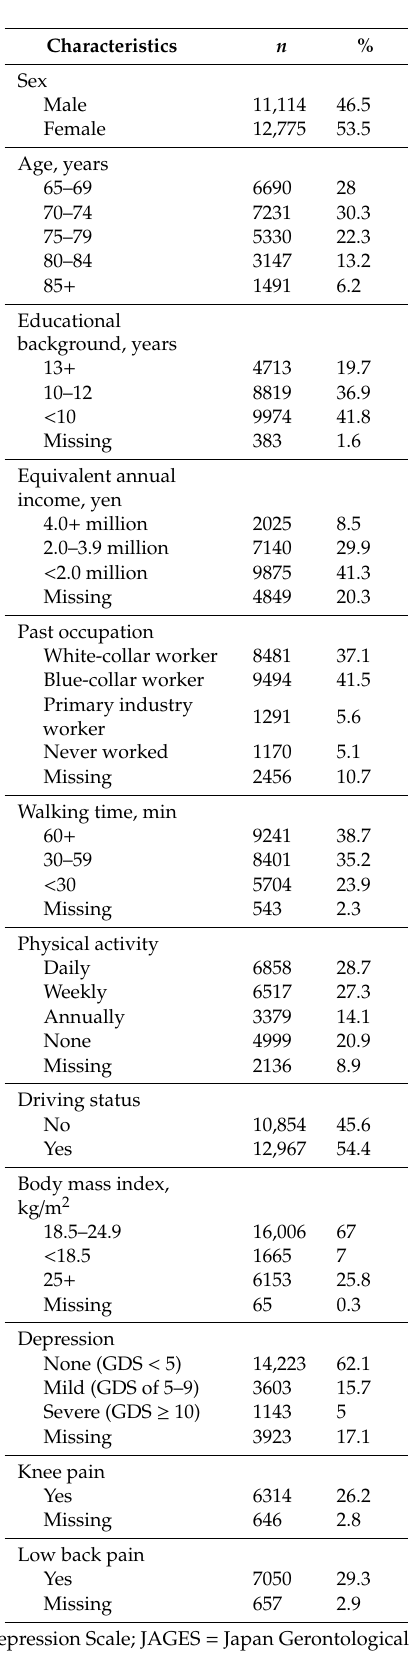
Table 1. Characteristics of older Japanese adults surveyed in JAGES 2013 with regard to neighborhood walkability ( n =